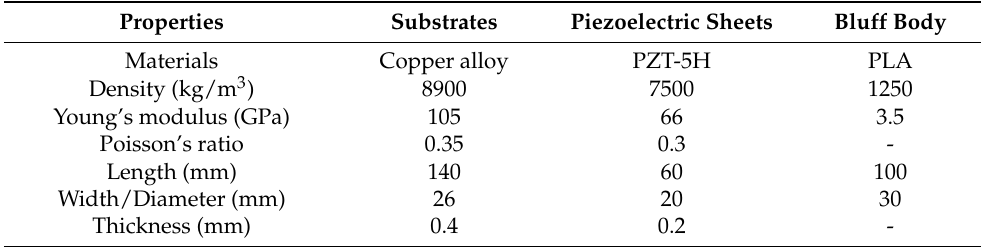
Figure 5. Enlarged view of VEH-30. Table 4. Materials and parameters of each part of the VEH-30.